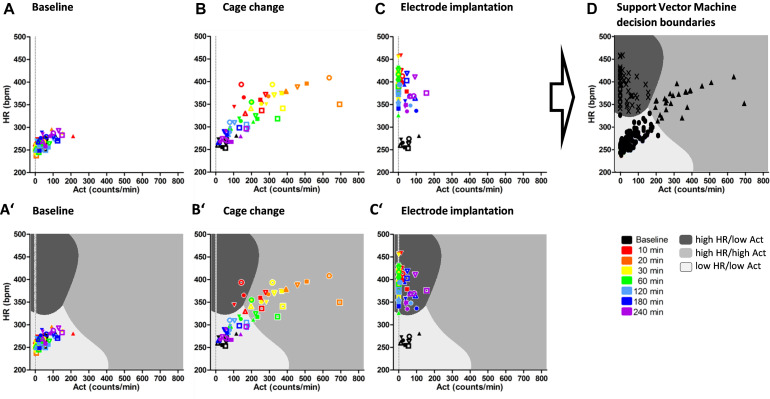
Development of classification model in SD rats. Heart rate (HR; bpm) and activity (Act; counts/min) until 4 h after experimental procedures of baseline as no stress (A), cage change as stress-like response inducing procedure (B), and electrode implantation as distress (C). (A–C) served as training data set for development of Support Vector Machine (SVM) decision boundaries map (D) with blinded training data set (black symbols). SVM identified three classes: dark gray: high HR/low Act, midgray: high HR/high Act, light gray: low HR/low Act. Overlay of training data and decision boundaries (A’–C’). HR is shown as mean, and Act is shown as sum over 10 min starting at the indicated time points (color-coded). Symbols indicate different animals.